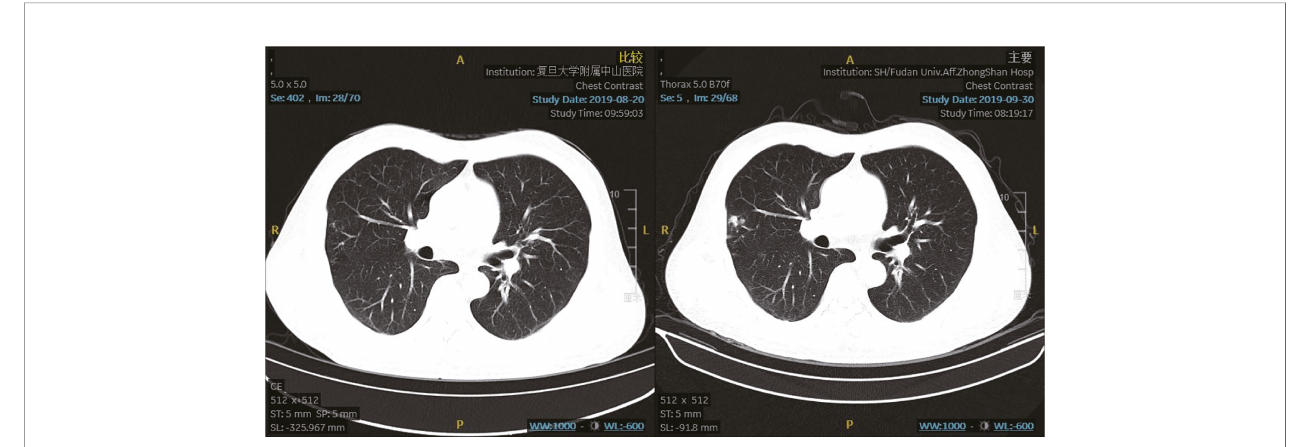
FIGURE 3 | Chest computed tomography scan. The chest computed tomography lung window (left picture 20 August 2019; right picture 30 September 2019) shows new nodules on the lateral edge of the right lung, which may suggest in fl